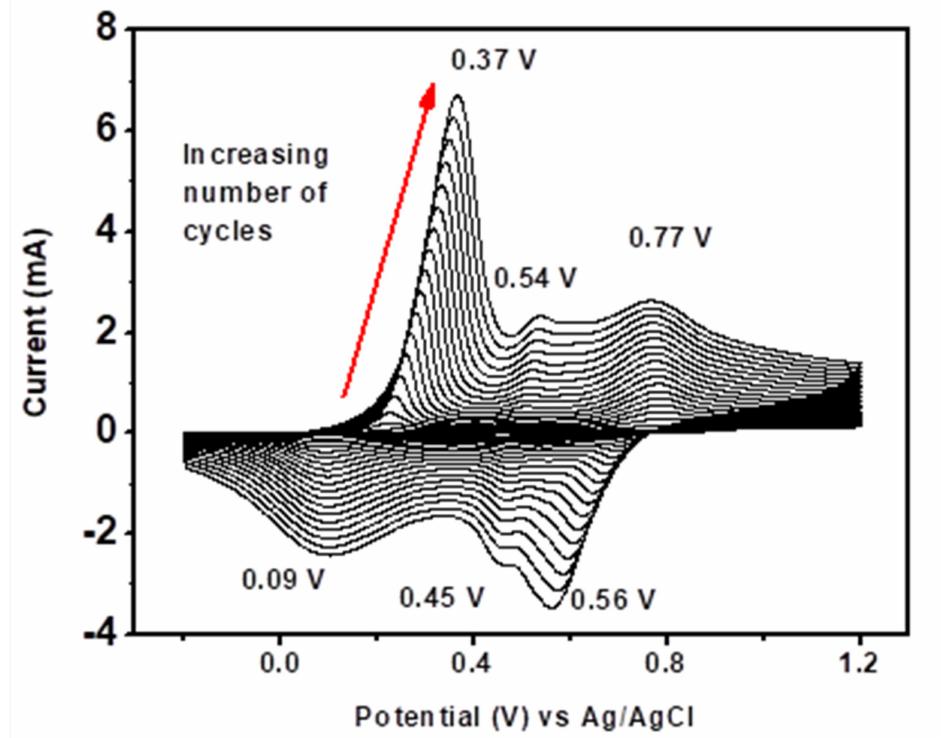
Figure 6. Cyclic voltammograms for the electrosynthesis of PANI on a GCE in 1 M HCl, at a scan rate of 50 mV/s, for 40